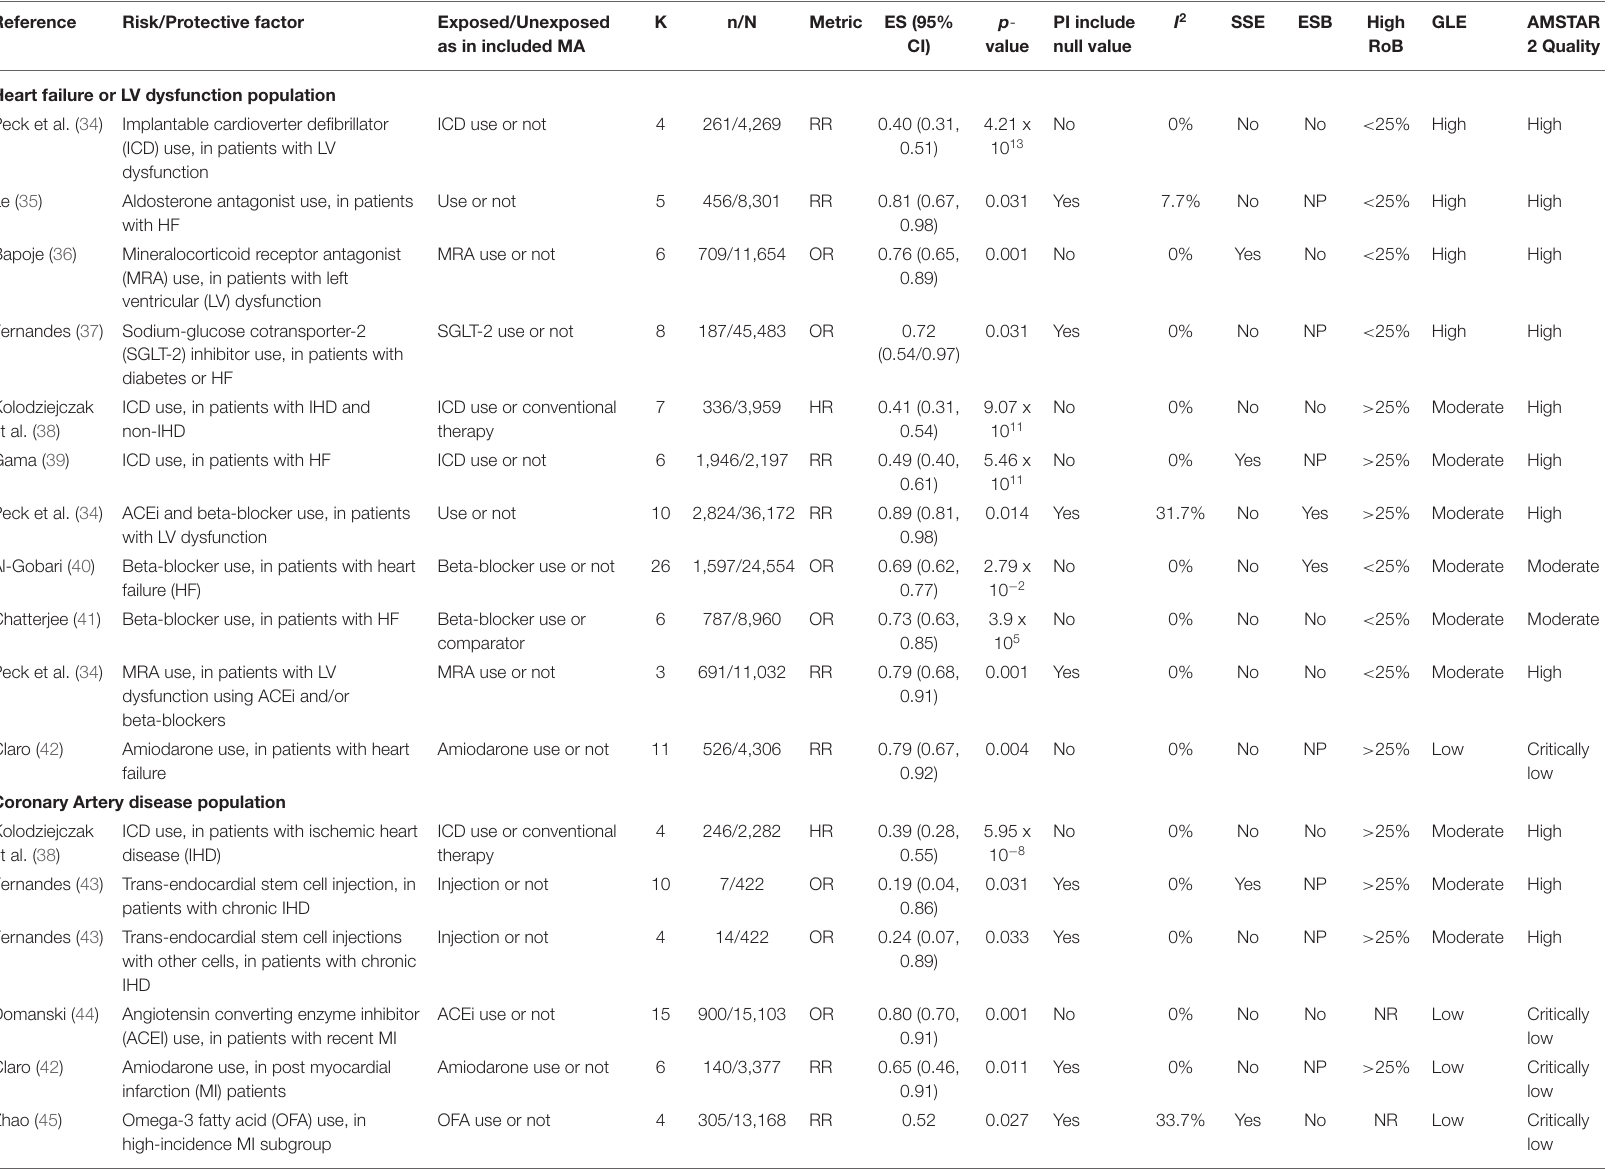
TABLE 2 | Significant associations of interventions with the risk for sudden cardiac death, in meta-analyses of randomized controlled trials.